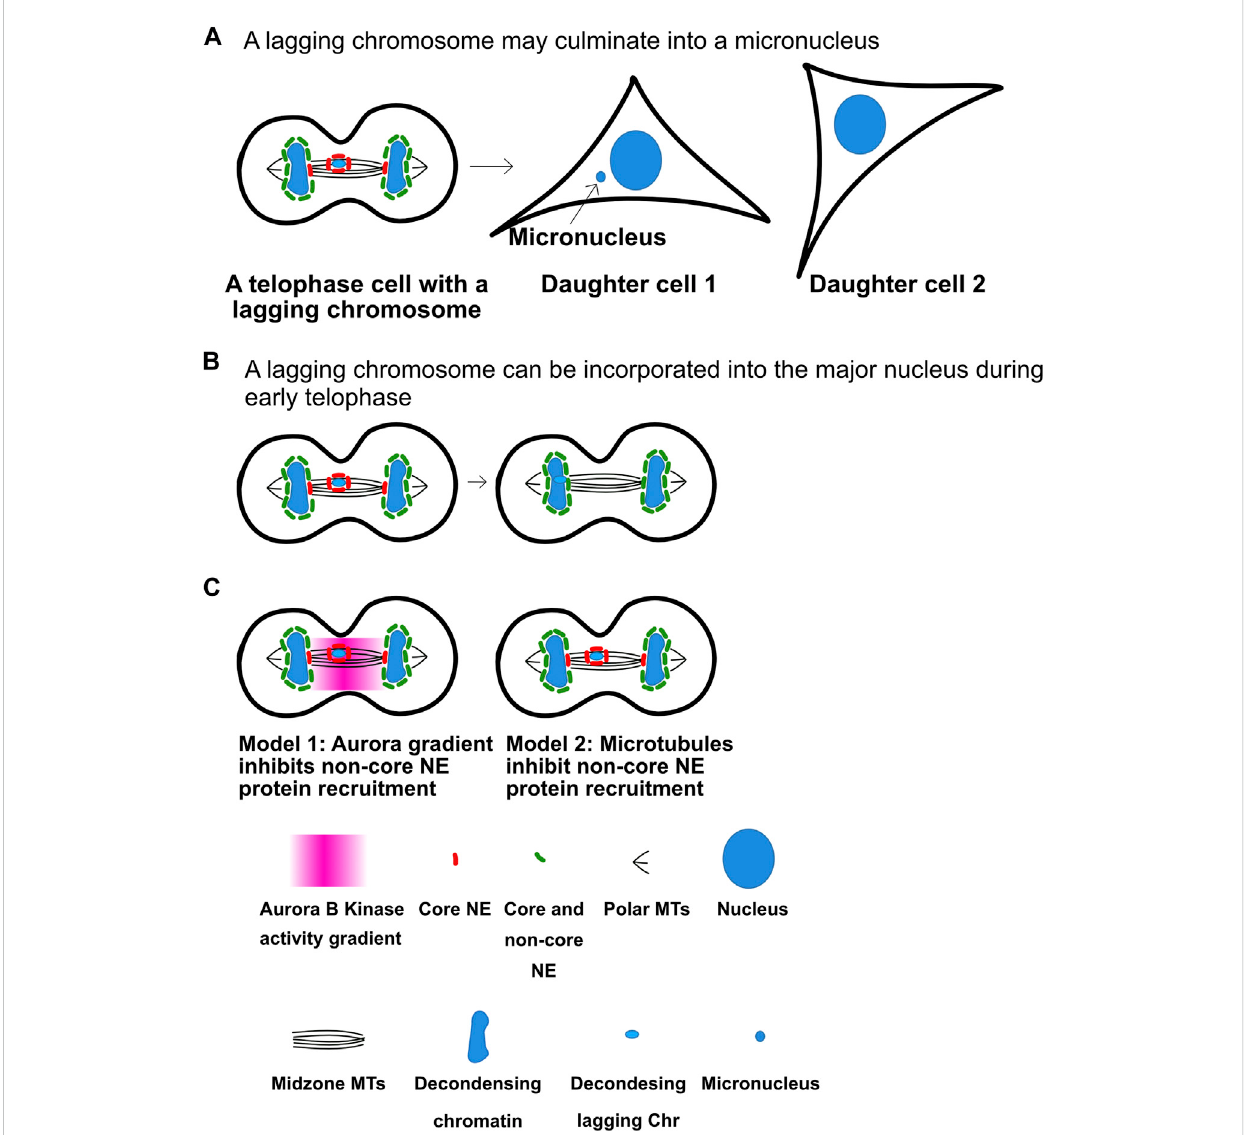
FIGURE 4 Anaphase Aurora B kinase gradients may regulate nuclear envelope assembly to limit micronuclei formation. (A) Decondensing chromosomes may culminate in the formation of micronuclei in the next G1. (B) Lagging chromosomes between chromosome masses do not recruit non-core nuclear envelope proteins, which allows them to be incorporated in the main nucleus. As cells enter telophase nuclear envelope formation begins on all chromatinmasses.Segregatedchromosomemassescanrecruitbothcoreandnon-corenuclearenvelopeproteins(Green)toformnormalnuclear envelopes. However, lagging chromosomes only bind a set of nuclear envelope proteins known as core proteins (Red) but cannot recruit non-core proteins. This is believed to have two consequences. First, it allows chromosomes that arrive late to incorporate into the major nucleus and prevent micronuclei formation. Second, if the lagging chromatids are not incorporated in the major nucleus by telophase they become micronuclei that are de fi cient in the ability to form nuclear pores and also easily rupture. (C) There are two models for the mechanisms that prevent the non-pore nuclear envelope proteins from assembling. The fi rst model posits that the Aurora B gradient prevents the binding. The second argues that bundles of microtubules prevent the non-pore proteins from binding. Note the in both model ’ s chromosomes that are not between segregating chromosomes cannot recruit non-pore proteins and become micronuclei. It will be important to determine the mechanisms to distinguish between the two models. Figure representation: De-condensing chromosomes, blue; Nucleus, large blue ovals; Micronucleus, small blue oval; Microtubules, black lines; Core NE proteins, red bean shape; Core and non-core NE proteins, green bean shape; Pink heat map represents Aurora B kinase activity gradient. Abbreviation: NE, Nuclear